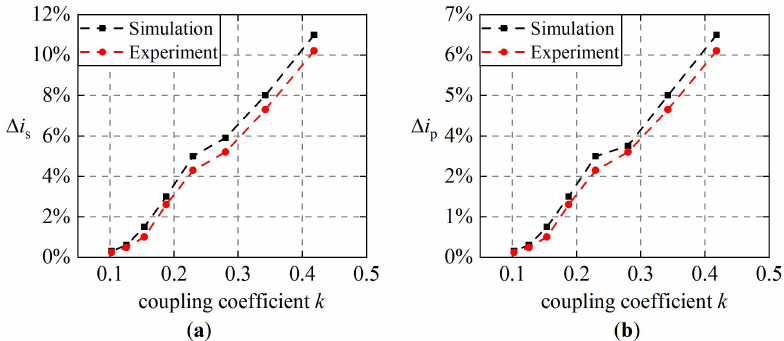
Figure 20. The fluctuations of secondary and primary currents with simulation and experiment under different coupling coefficients. ( a ) Forward communication. ( b ) Backward